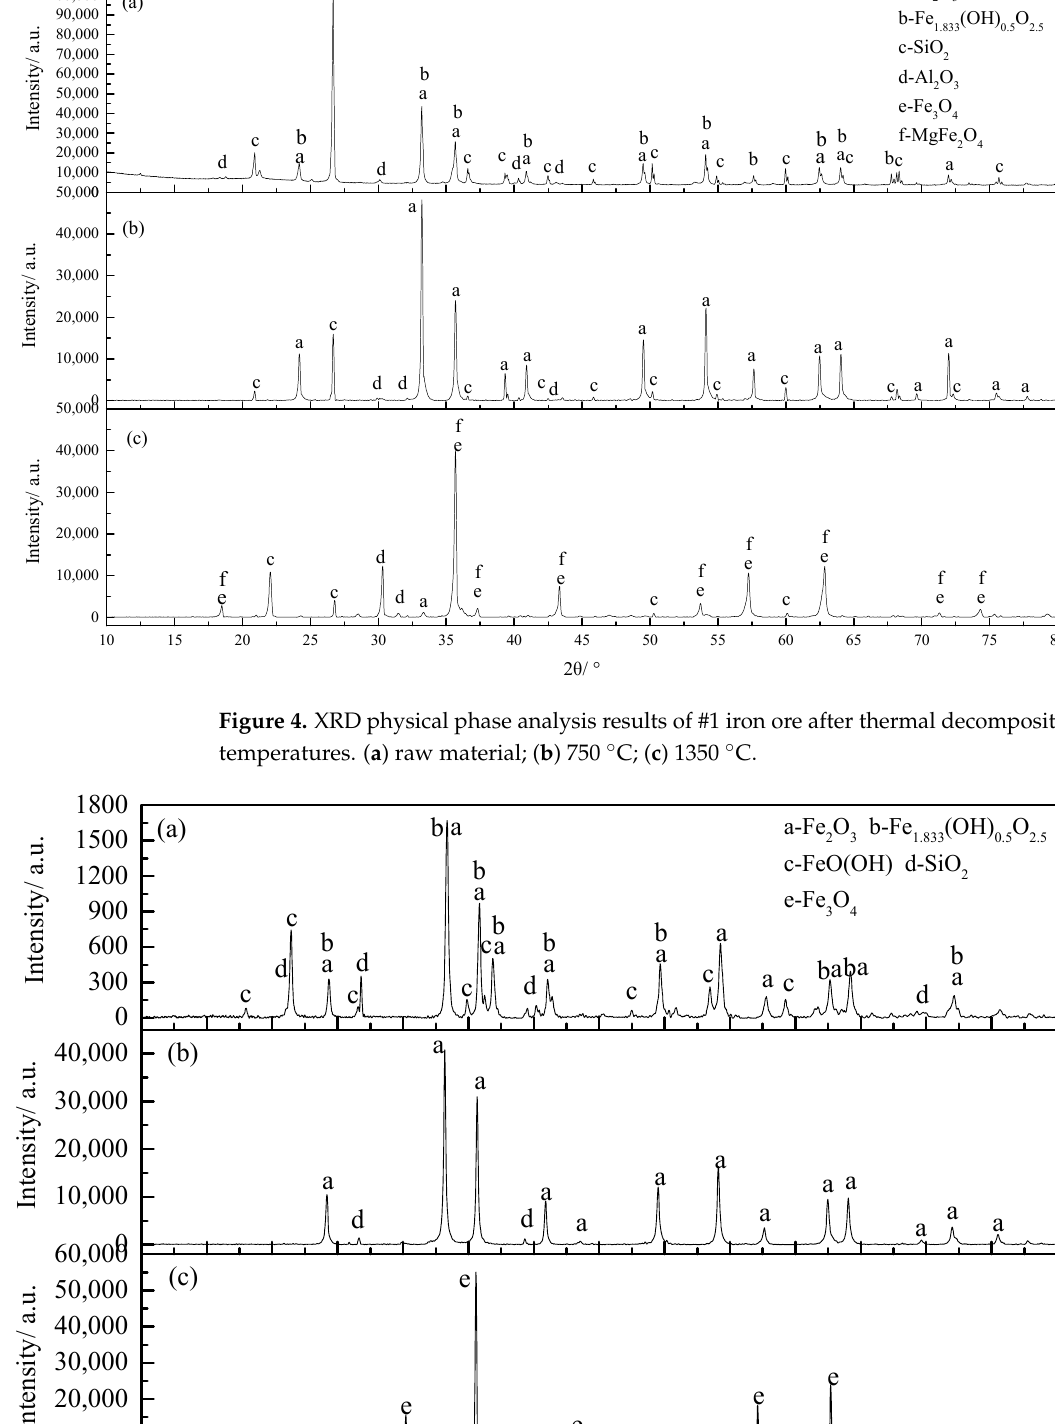
Figure 6. Internal cracking microstructure during the smelting reduction of #1 iron ore. ( a ) Micro- structure of cracks at 4 s with 100 μ m scale; ( b ) Microstructure of cracks at 4 s with 10 μ m scale; ( c ) Microstructure of cracks at 8 s with 100 μ m scale; ( d ) Microstructure of cracks at 8 s with 10 μ m scale; ( e ) Microstructure of cracks at 12 s with 100 μ m scale; ( f ) Microstructure of cracks at 12 s with 100 μ m scale; ( g ) Microstructure of cracks at 16 s with 20 μ m scale; ( h ) Microstructure of